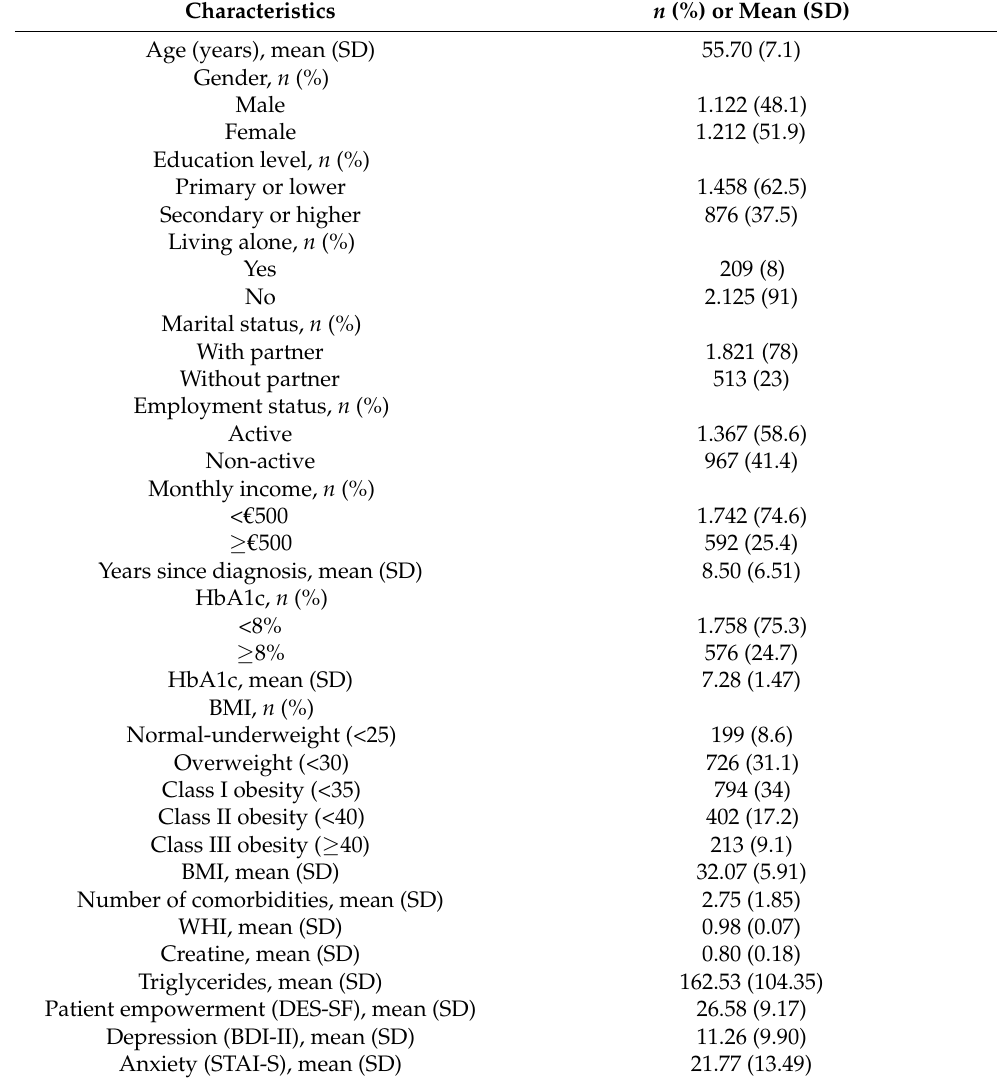
Table 2. Sociodemographic and clinical